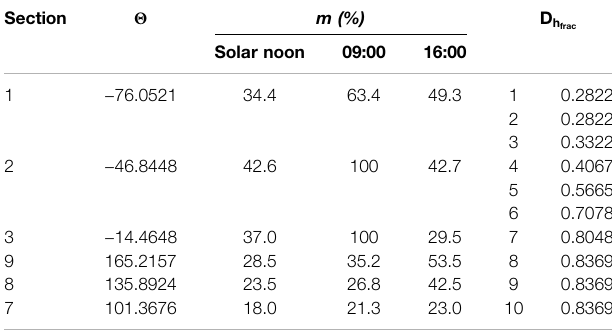
values for all the frac